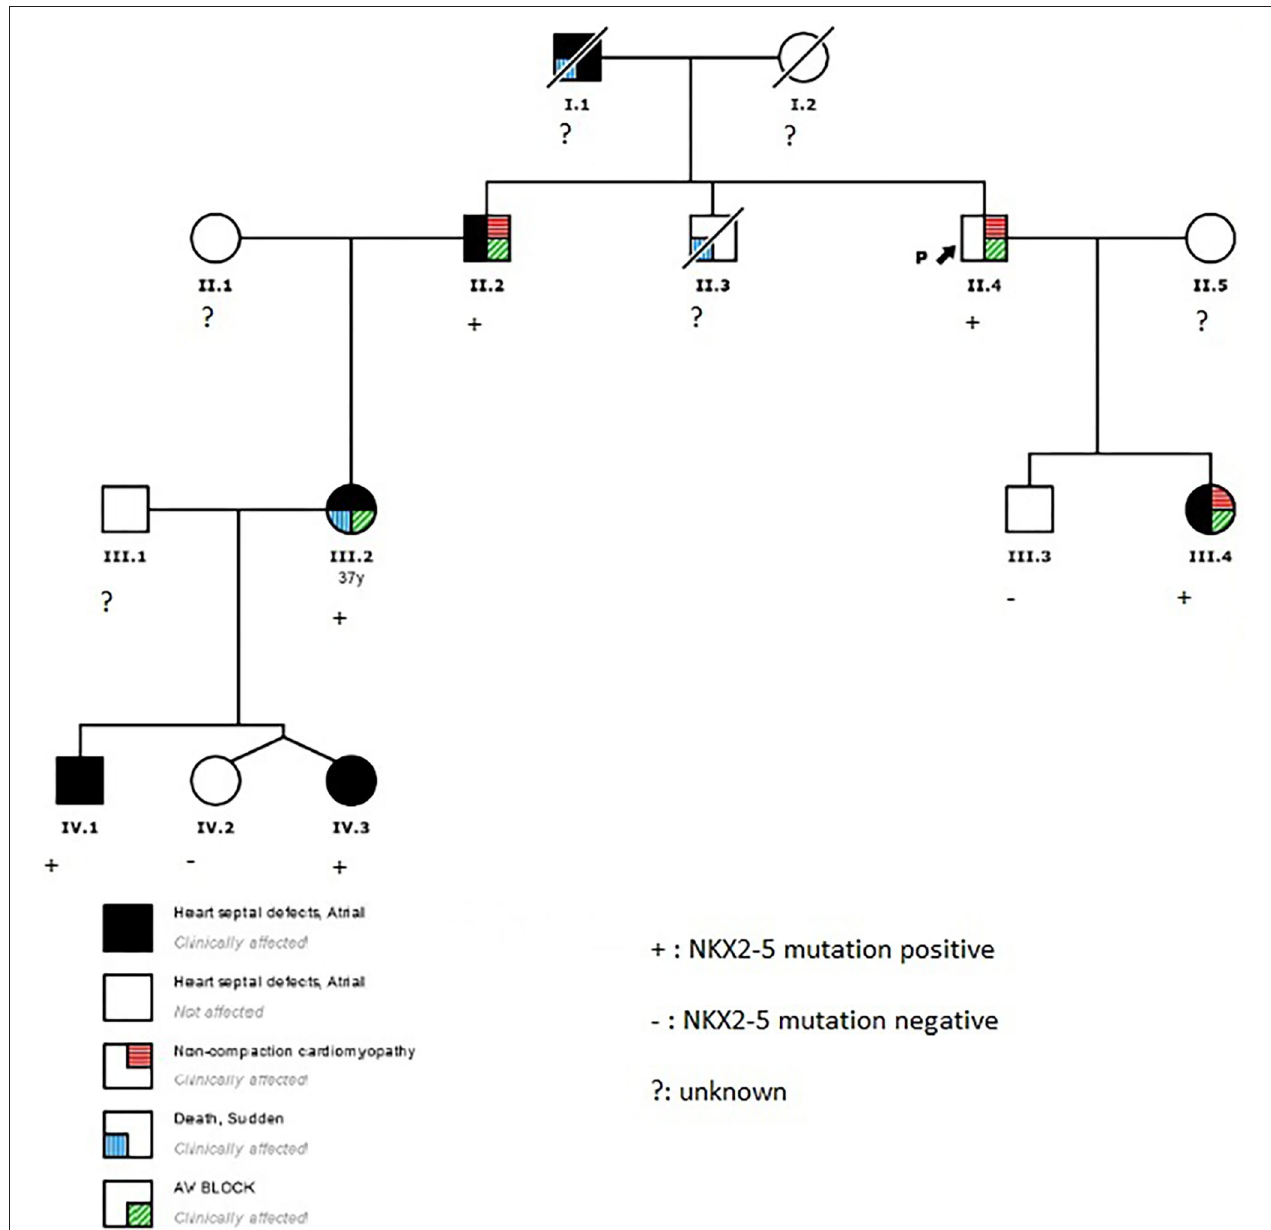
FIGURE 1 | Family pedigree. Black arrow, proband; square, male; circle, female; black, heart septal defects; white, not affected; diagonal stripe, death; red lines, non-compaction cardiomyopathy; blue lines, sudden death; green lines, atrioventricular block.